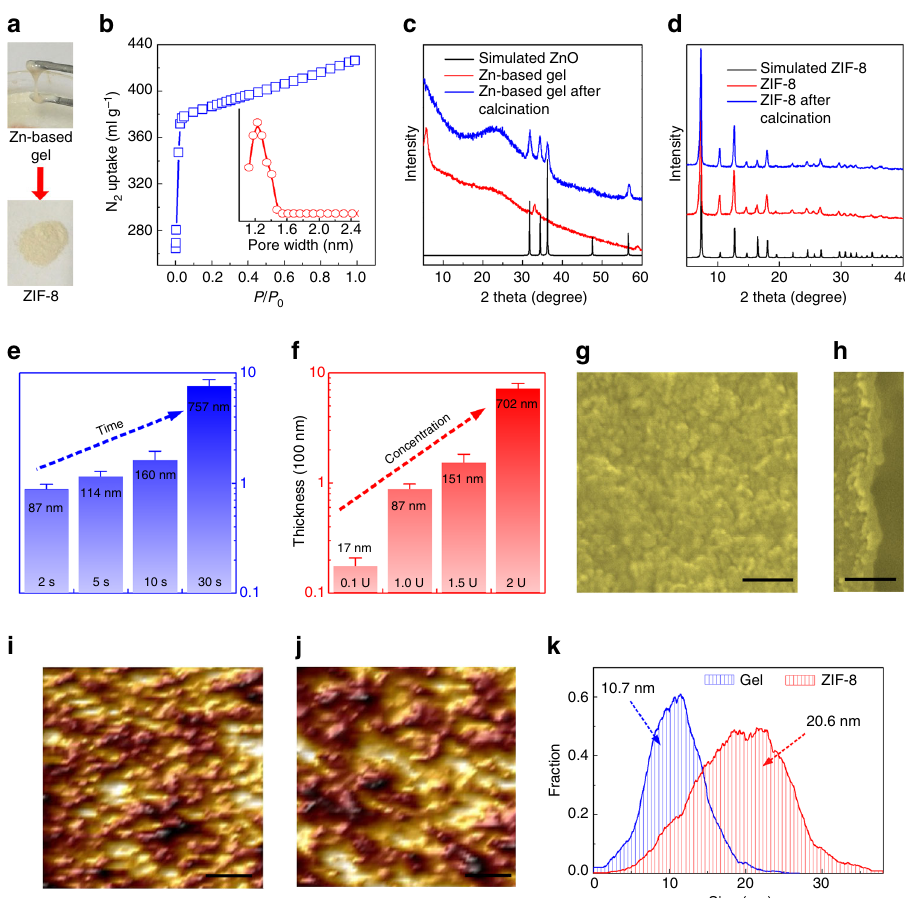
Fig. 2 Characterizations and thickness of ZIF-8 membranes. a The optical photographs of the Zn-based gel and the ZIF-8 powder. b N 2 adsorption isotherm and corresponding pore width distribution of the prepared ZIF-8. c XRD patterns of the simulated ZnO, the Zn-based gel layer and the calcinated Zn-based gel layer on PVDF hollow fi bres. d XRD patterns of the simulated ZIF-8, the ZIF-8 membrane and the calcinated ZIF-8 membrane. The samples were prepared with sol concentration of 1 U, coating time of 2 s and vapour deposition time of 2 h. Thickness of ZIF-8 membranes prepared with different e coating time and f sol concentration. The thickness was measured at various locations to obtain the standard deviation. g Top and h cross-sectional view SEM images of the ZIF-8 membrane. Scale bar , 200 nm. AFM analysis of i the Zn-based gel layer and j the ZIF-8 membrane. R q : i 3.6 nm and j 5.8